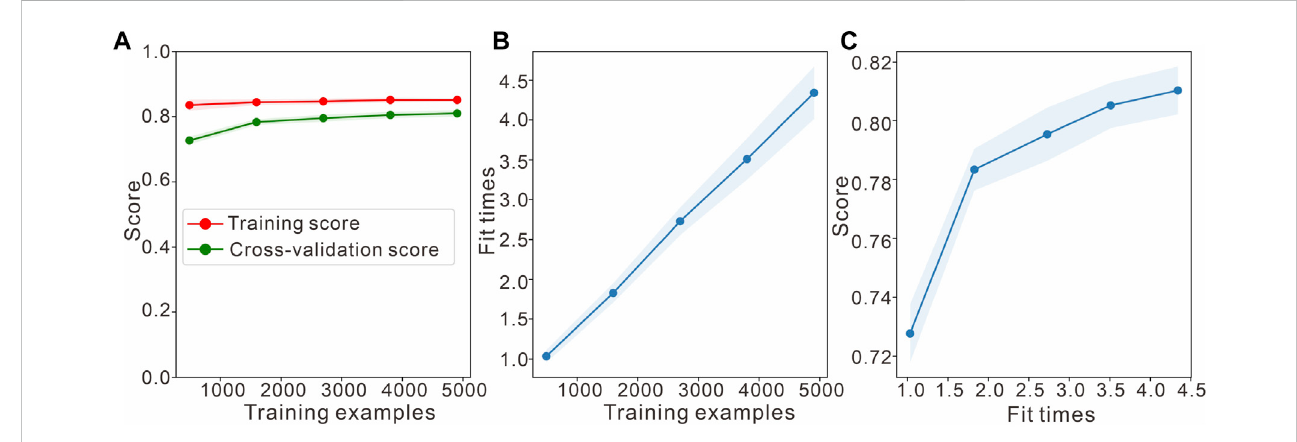
FIGURE 12 Learning curve of the Bayesian classi fi er for the inversion of J 1 s 2 . (A) Naive Bayes learning curves. (B) Scalability of the model. (C) Performance of the model. Fit times indicates the convergence time of the model training.